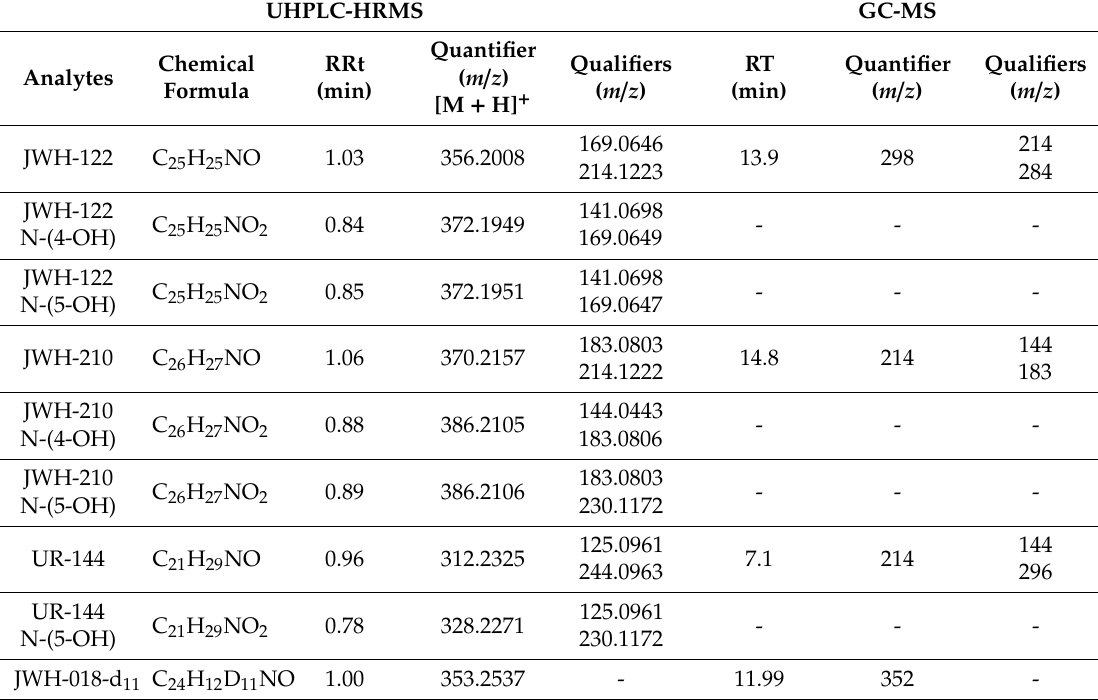
Table 3. UHPLC-HRMS and GC-MS MS parameters and relative retention time (RRt) in targeted MS / MS and SIM mode,